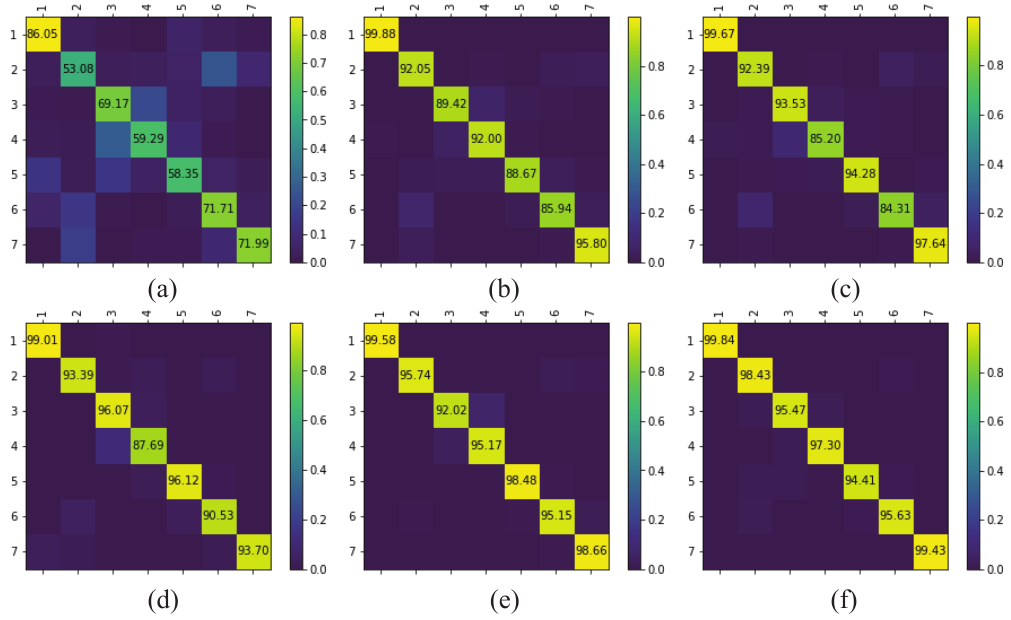
Figure 15. Normalized confusion matrices of classification results for the Grss_dfc_2014 data. ( a ) CNN. ( b ) M3DCNN. ( c ) SSRN. ( d ) MSDN-SA. ( e ) MSO3DCNN. ( f )